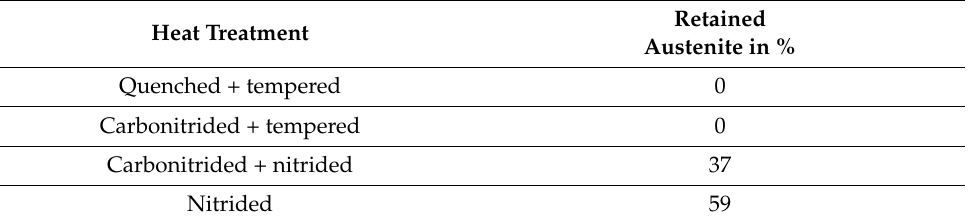
Table 4. Retained austenite in the surface area after one cycle of induction heating and quenching.